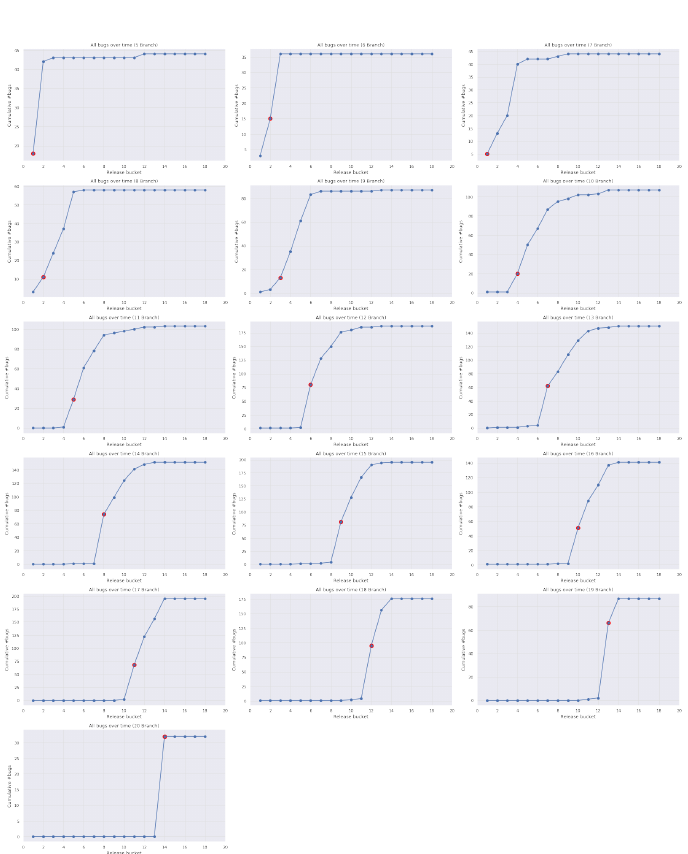
Figure 3. Fit of individual branches or features in the data set, the red dot is the first data point estimated. Here, each branch is considered as a feature which are plotted